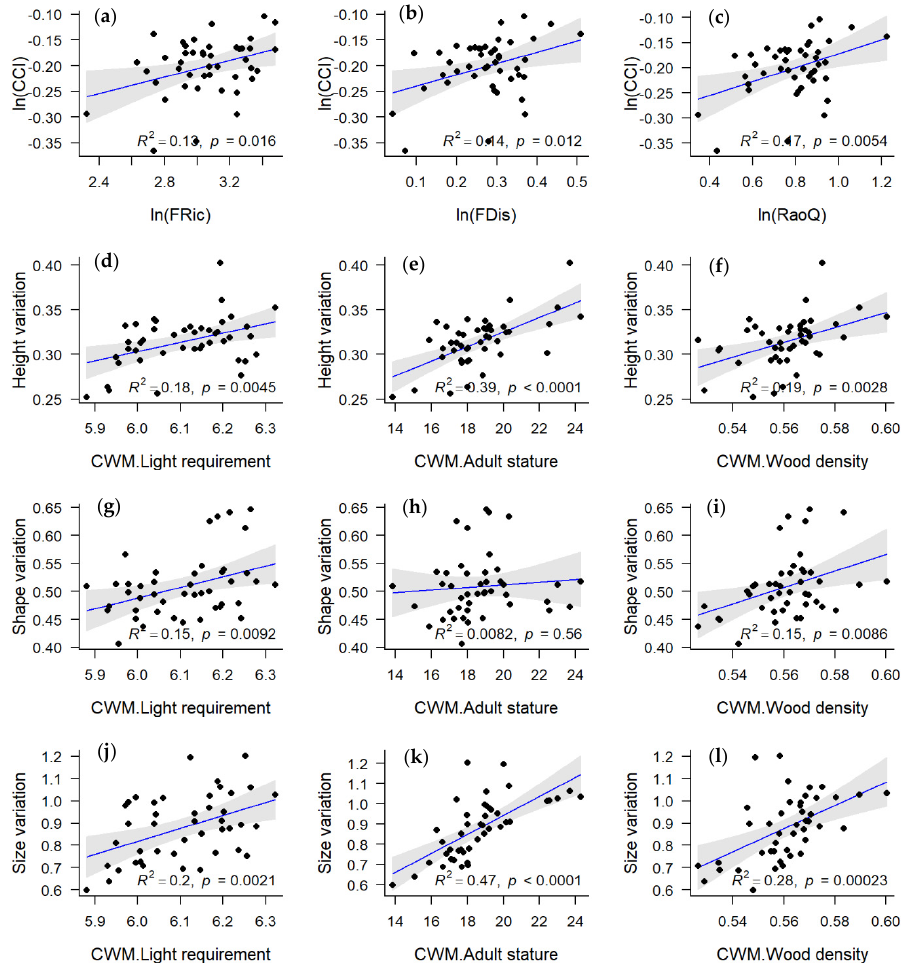
Figure 2. Bivariate relationships between crown spatial complementarity and functional diversity. The upper three scatter plots ( a – c ) capture crown complementarity index vs. ( a ) functional richness (FRic), ( b ) functional dispersion (FDis) and ( c ) the Rao’s quadratic entropy (RaoQ). The 9 plots in the lower panel capture the regressions between variations in tree height ( d – f ), crown shape ( g – i ) and crown size ( j – l ) and community-weighted mean of shade tolerance, adult stature and wood density, respectively. The R 2 and p -values are shown.